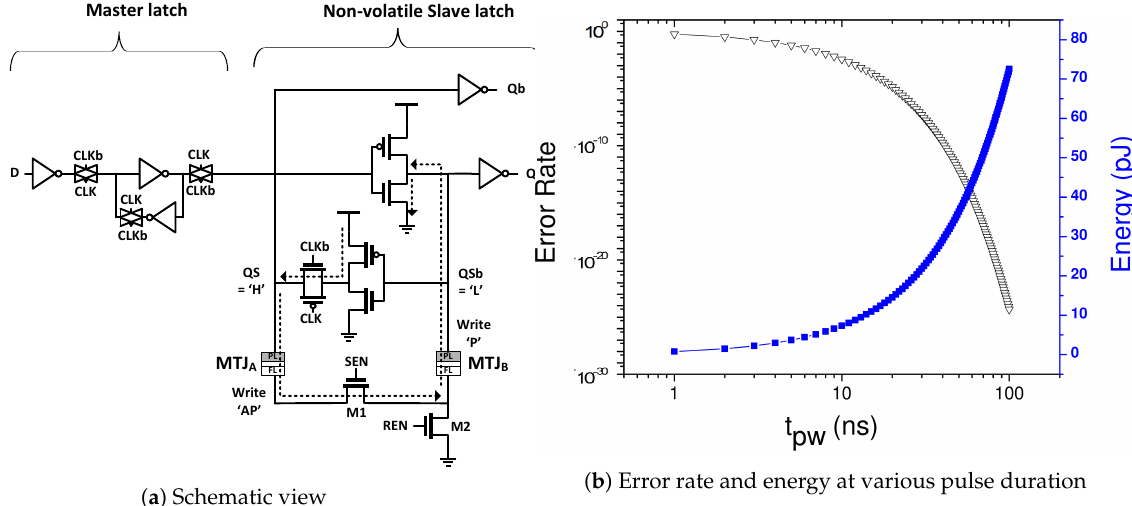
Figure 13. An approximate non-volatile flip-flop proposed in